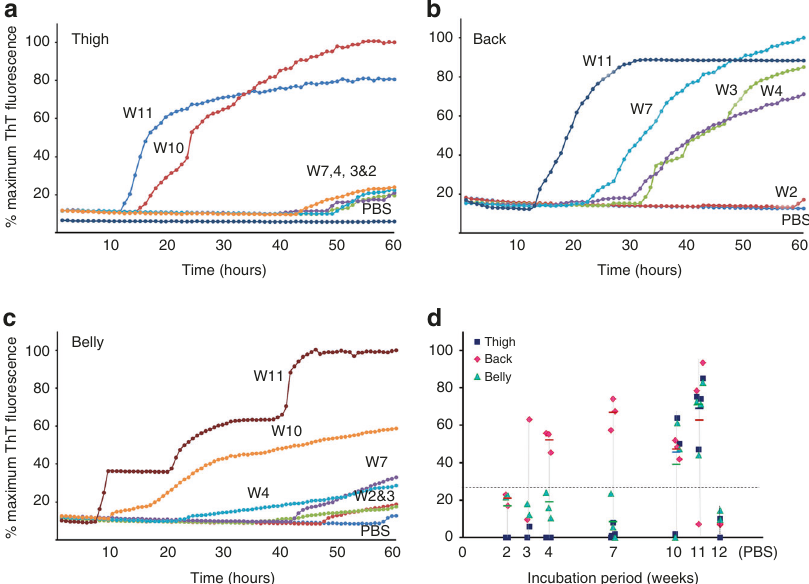
Fig. 2 Skin prion-seeding activity of infected hamsters at different time points. Prion-seeding activity of thigh a , back b , and belly c skin from 263K- inoculated hamsters sacri fi ced at 2, 3, 4, 7, 10, or 11 wpi and PBS-inoculated hamsters at 12 wpi detected by RT-QuIC assay. d Scatter plot of skin prion- seeding activity of thigh, back, or belly from 263K-inoculated hamsters at 2 ( n = 2), 3 ( n = 2), 4 ( n = 3), 7 ( n = 3), 10 ( n = 3), or 11 ( n = 4) wpi and PBS- inoculated hamsters killed at 12 ( n = 2) wpi. The horizontal dotted line indicates the 27% calculated ThT fl uorescence threshold based on the means of negative controls plus 4 s.d.